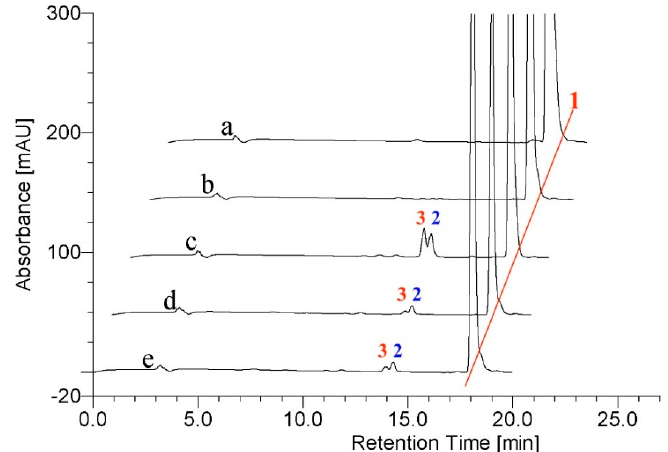
Figure 9. ( a ) HPLC profile of 17 α -hydroxyprogesterone; ( b – e ) 17 α -hydroxyprogesterone incubations with empty vector. M01A82W. M01A82WS72I and M11A82W, respectively. Peak 1 shows a 17 α -hydroxyprogesterone standard; peaks 2 and 3 show the two monohydroxylated metabolites of 17 α -hydroxyprogesterone.